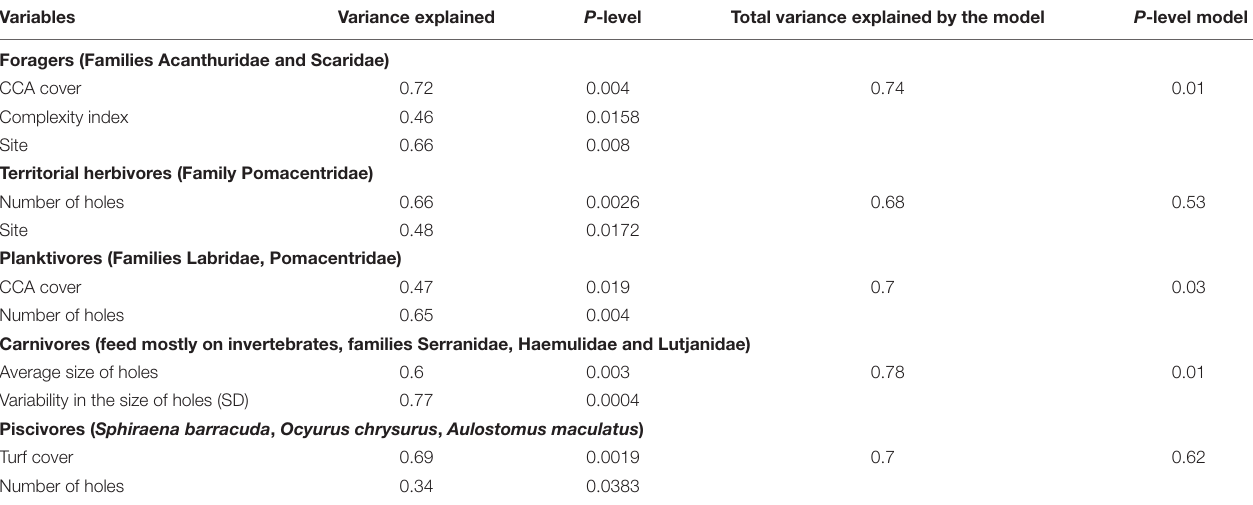
TABLE 3 | Variables selected to construct linear models based on distances that best explained variation in biomass of fish with different trophic roles. Variables Variance explained P -level Total variance explained by the model P -level